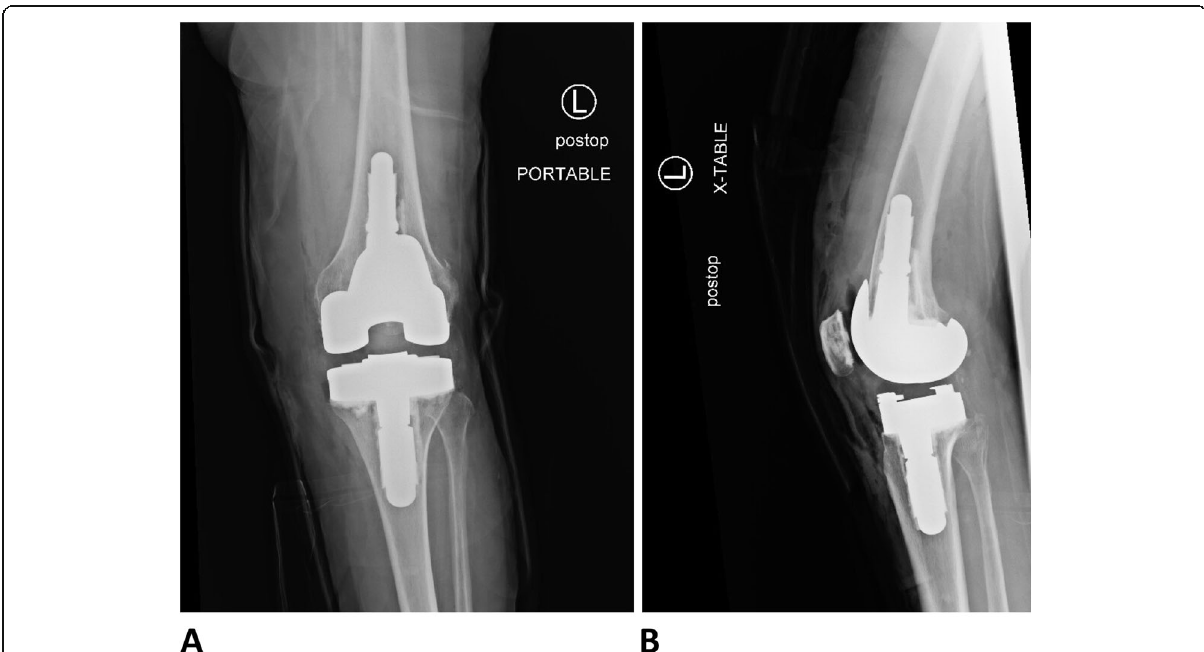
Fig. 2 Postoperative radiographs demonstrating successful revision to a total knee arthroplasty using the Zimmer Biomet Vanguard 360 Revision Knee System ( a ) AP view ( b ) lateral